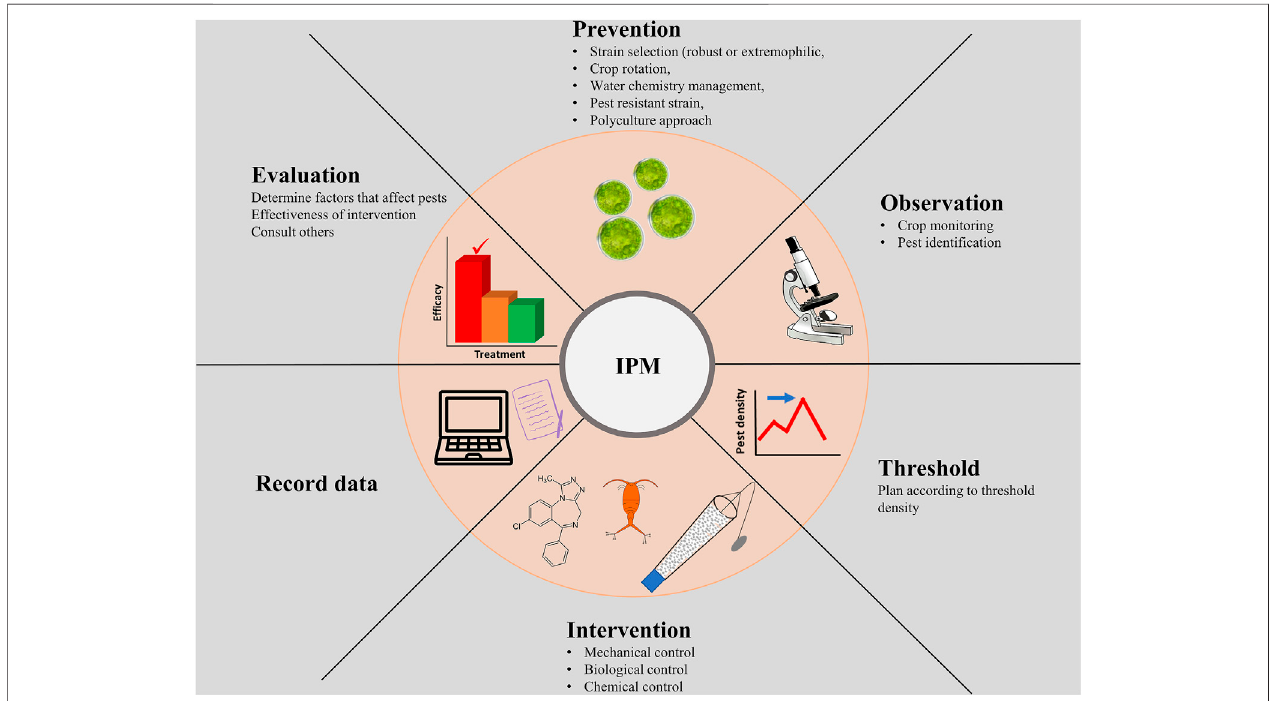
FIGURE 1 | Integrated pest management process for microalgae cultivation.